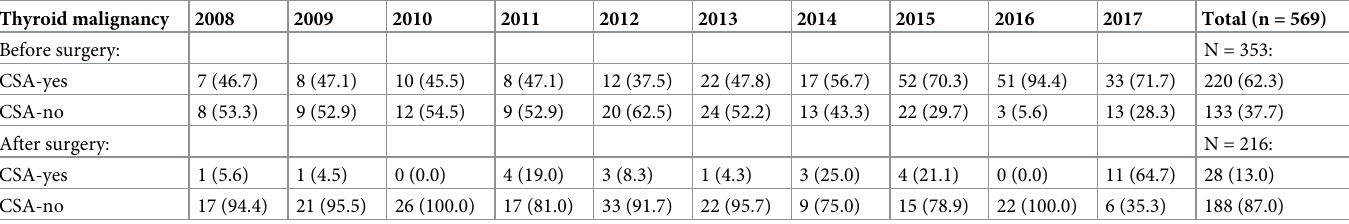
Table 4. Comparison of thyroid cancer diagnosis (before surgery vs after surgery) and cancer screening activity in TC patients from 2008–2017. Descriptive data are presented as numbers (percentages). Thyroid